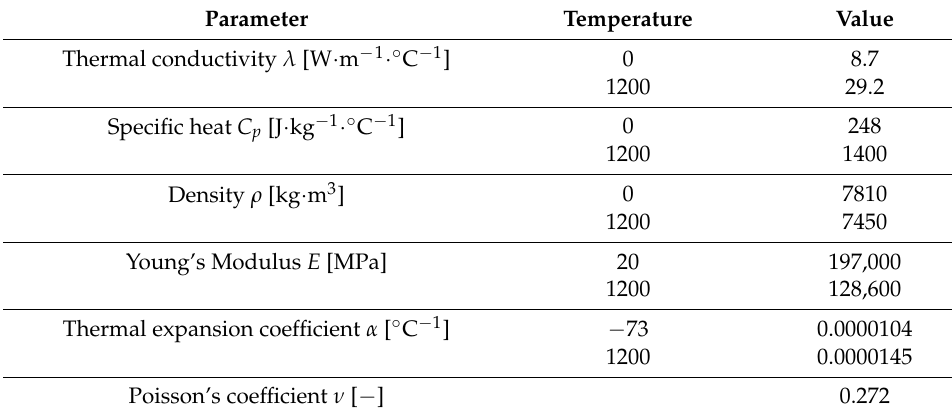
Table 2. Thermophysical properties of the 15-5PH workmaterial.